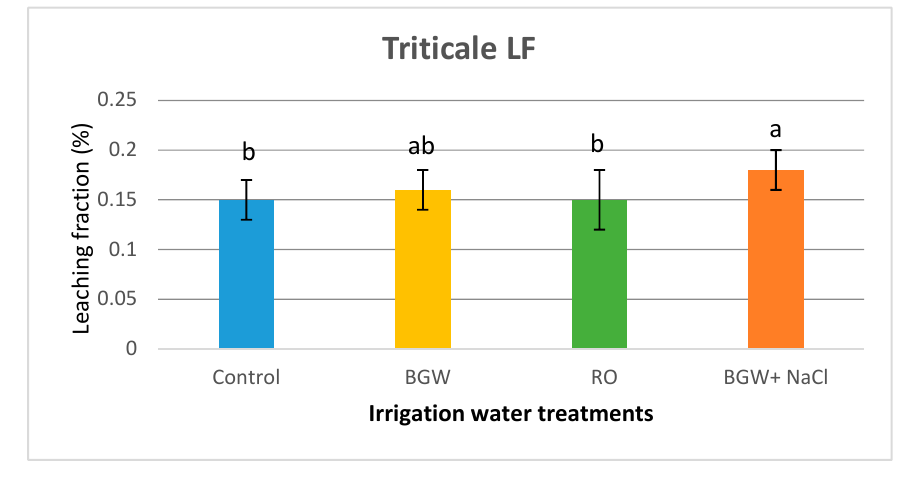
Figure 3. Leaching fractions (LFs) of alfalfa and triticale calculated with every irrigation in sand soils. Means within species sharing the same letter are not significant at α ≤ 0.05. Each observation is the mean ± SEs of four replications. The ECs of the saline treatments were control (0.7 dSm − 1 ), BGW (4 dSm − 1 ), RO (8 dSm − 1 ), and BGW + NaCl (8 dSm − 1 ).